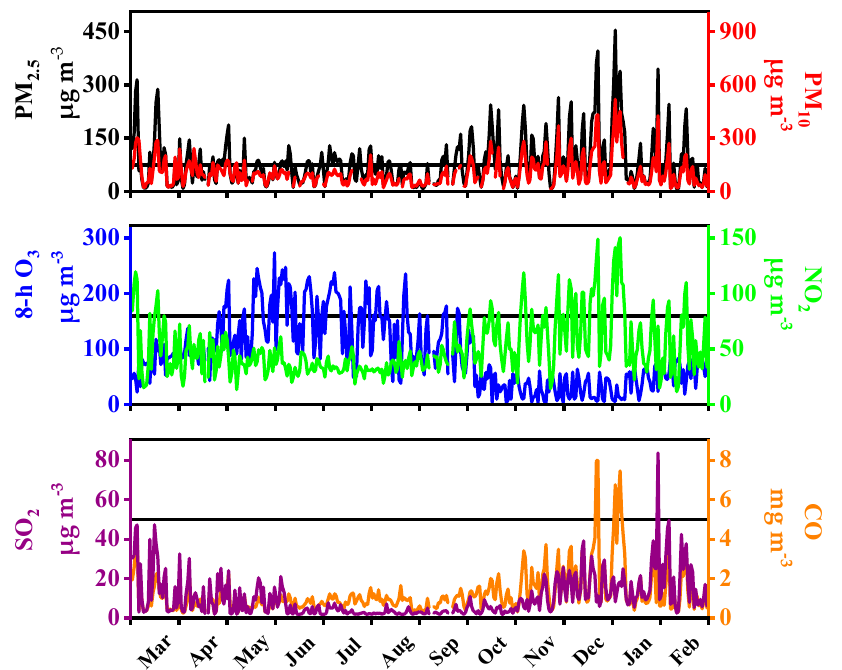
Figure 3. Daily average concentrations of PM 2.5 , PM 10 , CO, NO 2 , SO 2 , and 8-h O 3 in Beijing in 2016. The horizontal black lines represent the Grade II daily standards of Chinese Ambient Air Quality Standards (CAAQS) for PM 2.5 , PM 10 , NO 2 , and 8-h O 3 , the Grade I daily standards of CAAQS for SO 2 and CO.